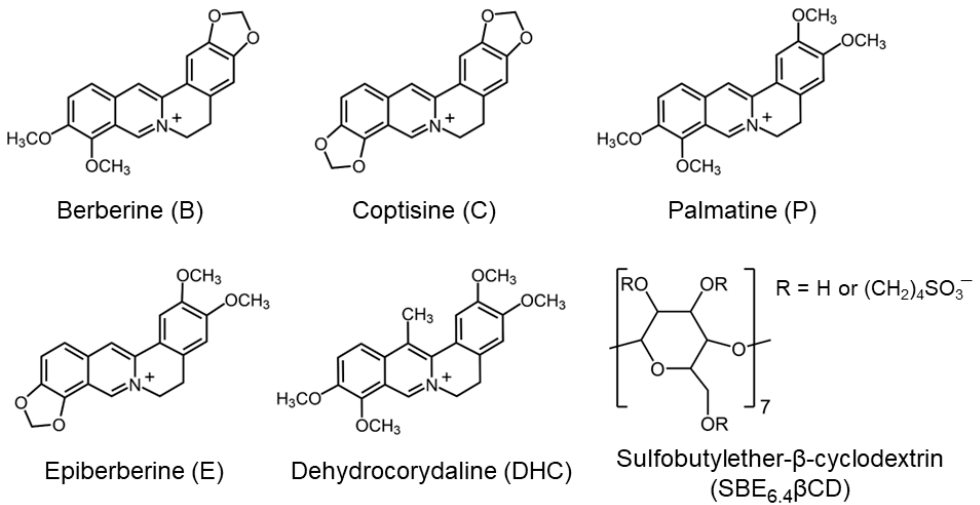
Figure 1. The structural formula of the guest and host